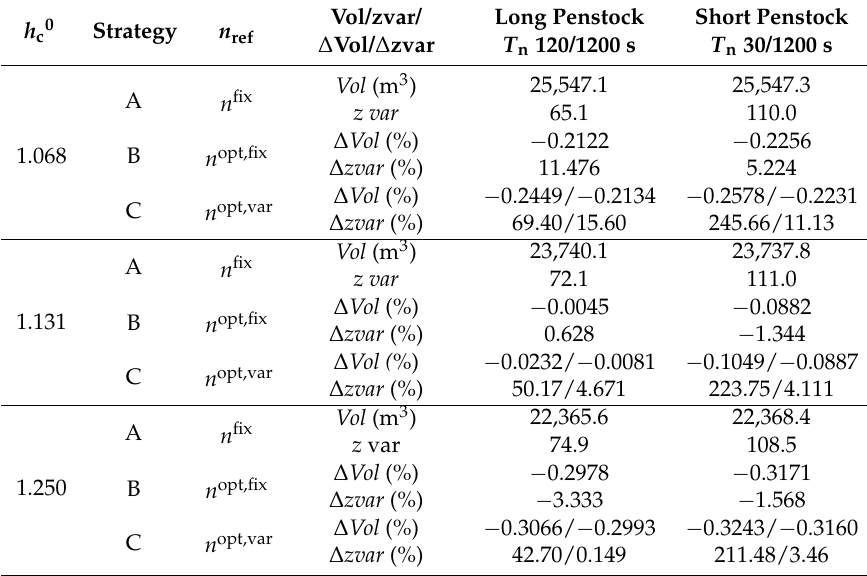
Table 10. Vol and zvar with the three control strategies, and different initial gross heads h c 0 , n fix = 1.0882